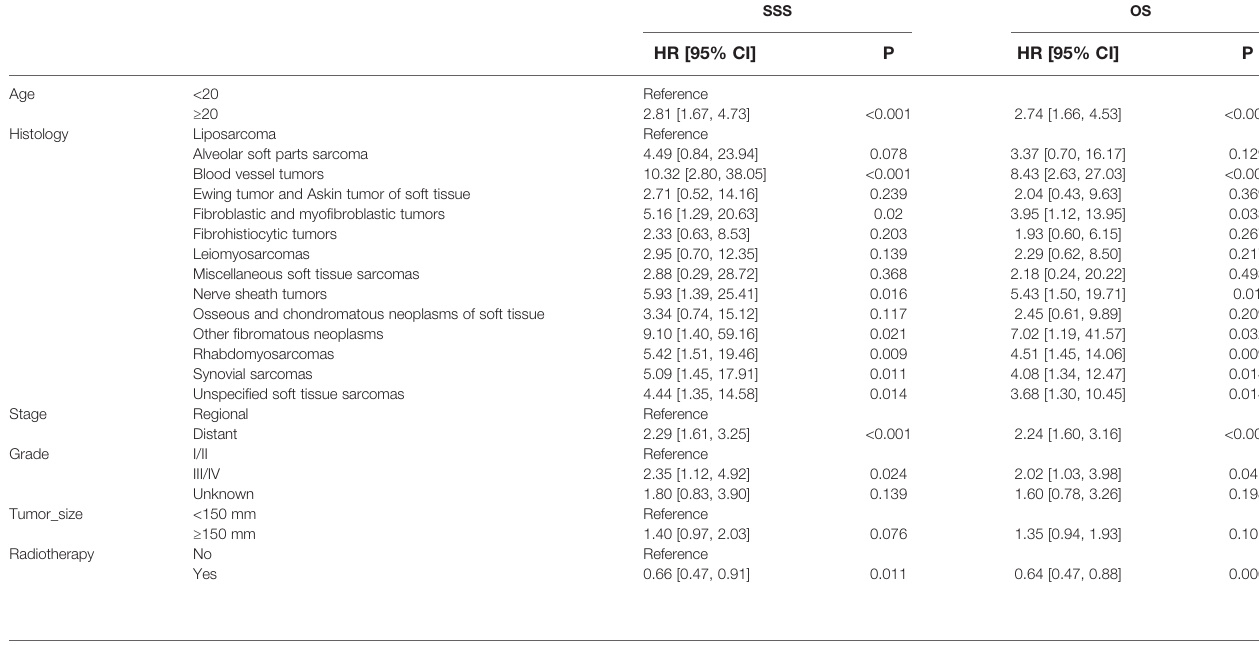
TABLE 4 | Multivariable Cox regression models for sarcoma-speci fi c survival and overall survival in patients with STSE-RLNM in the unadjusted cohort.